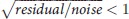
Linearity.A-C. Experimental example. (Re-plotted from data [17]): A-B. Two mitral odor kernels. Each kernel was obtained by linear fitting (least squared residual) of mitral responses to single-odor random pulse-trains (S2 Fig). C. Predicted response (magenta) using above kernels, to overlapping binary-odor pulse-trains (background bars in translucent red and blue), matches the mean mitral firing rate response (black line) shown with standard error of the mean (SEM) (gray width) over 12 trials. D-G. Model of linearity experiment. D. Model input. Air kernel and odor kernel (shared scale bars) were convolved with a constant suction pulse of air and an on-off random pulse-train of odor respectively, and added (along with a constant background) to generate the firing rate waveform of ORNs. The kernels have arbitrary units, as they are convolved with pulsed air-flow rate and odor-concentration pulse-trains, which have normalized units (to obtain mean air and odor firing rates), yielding ORN firing rate in Hz. E-G. Model results: Simulated example in default network, analogous to A-C above, except mean and SEM are over 9 trials. H-J. Goodness of linear fits and predictions: Fits / predictions with residual/noise < 1 are acceptable. Distribution of residual/noise for (top) fits of mitral responses to single-odor pulse-trains, and (bottom) predictions of responses to pulses of two odors overlapping in time. Last bin also contains all higher values. Standard deviation (SD) not SEM was used to calculate noise. H. Experimental data [17] re-plotted. I-J. Simulation results with: I. purely excitatory-component ORN kernels in 50 instances of default network (200 mitral-odor fits, 100 mitral-binary-odor predictions); and J. mixed i.e. excitatory- and inhibitory-component ORN kernels in 20 instances of the default network (80 mitral-odor fits, 40 mitral-binary-odor predictions). See also S2–S7 Figs.